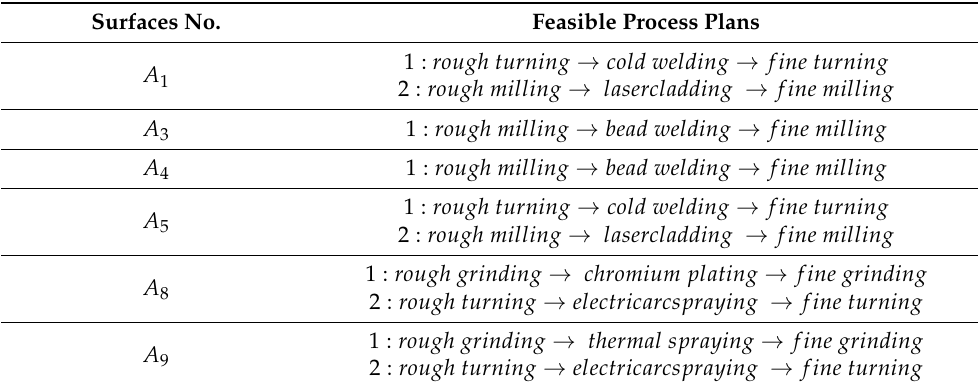
Table 4. Feasible process plans of each failure surfaces of a used gearbox.